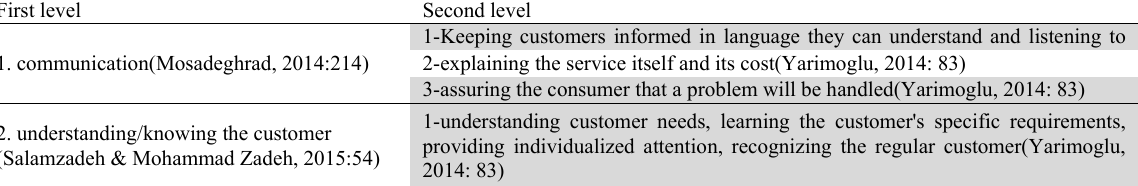
Factors related to communications with customers at abstract and concrete levels First level Second